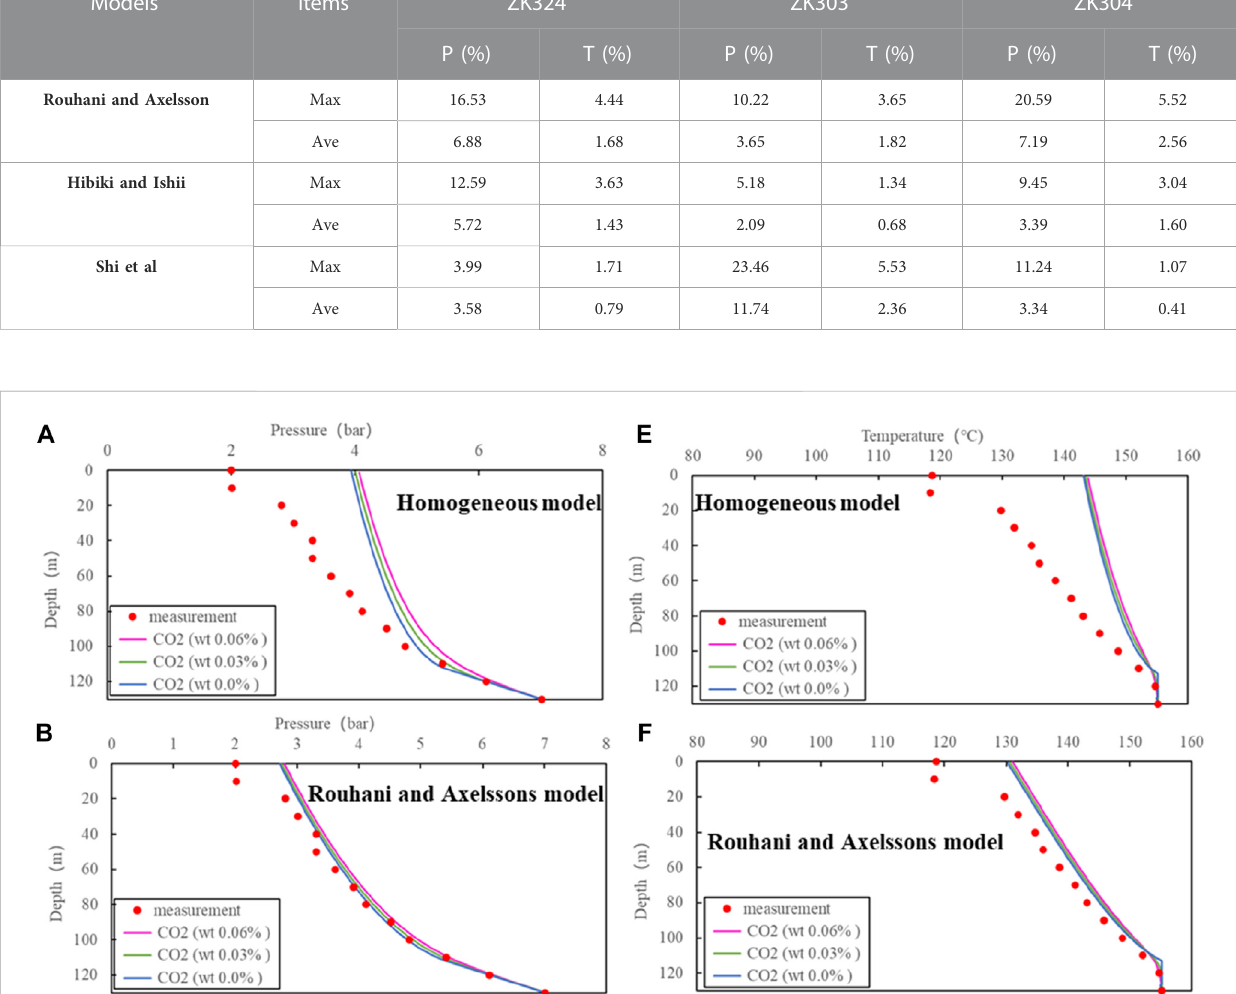
Frontiers in Earth